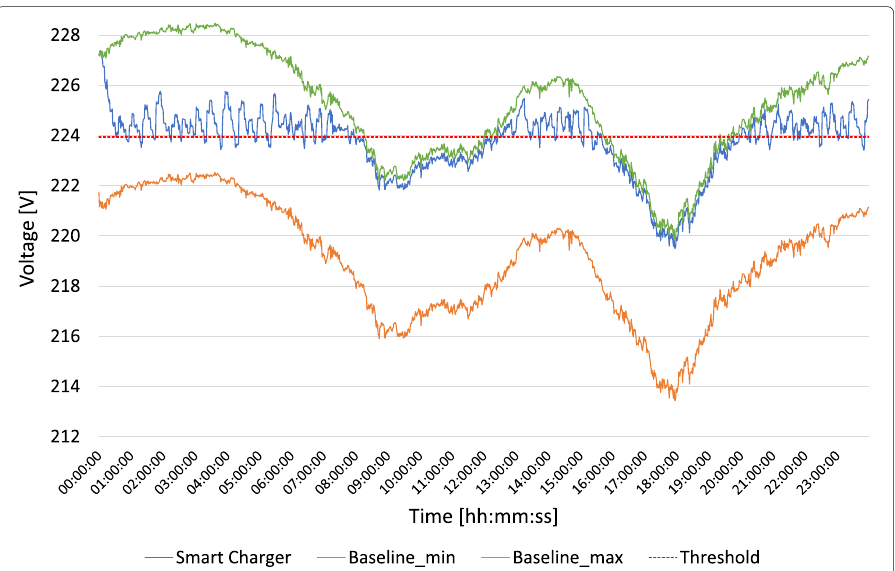
day with a minimum value of 213.5 V.